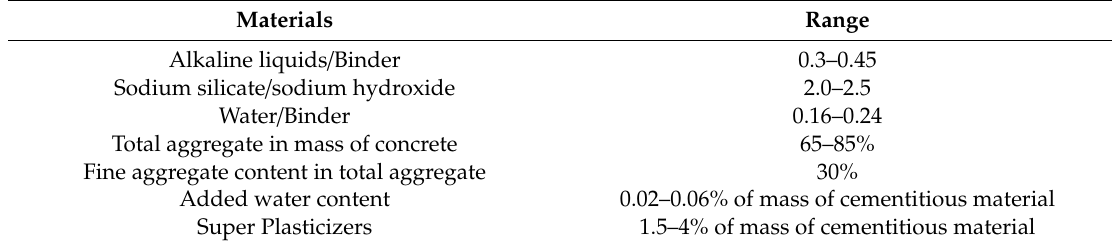
Table 4. Standards of materials used in geopolymer concrete